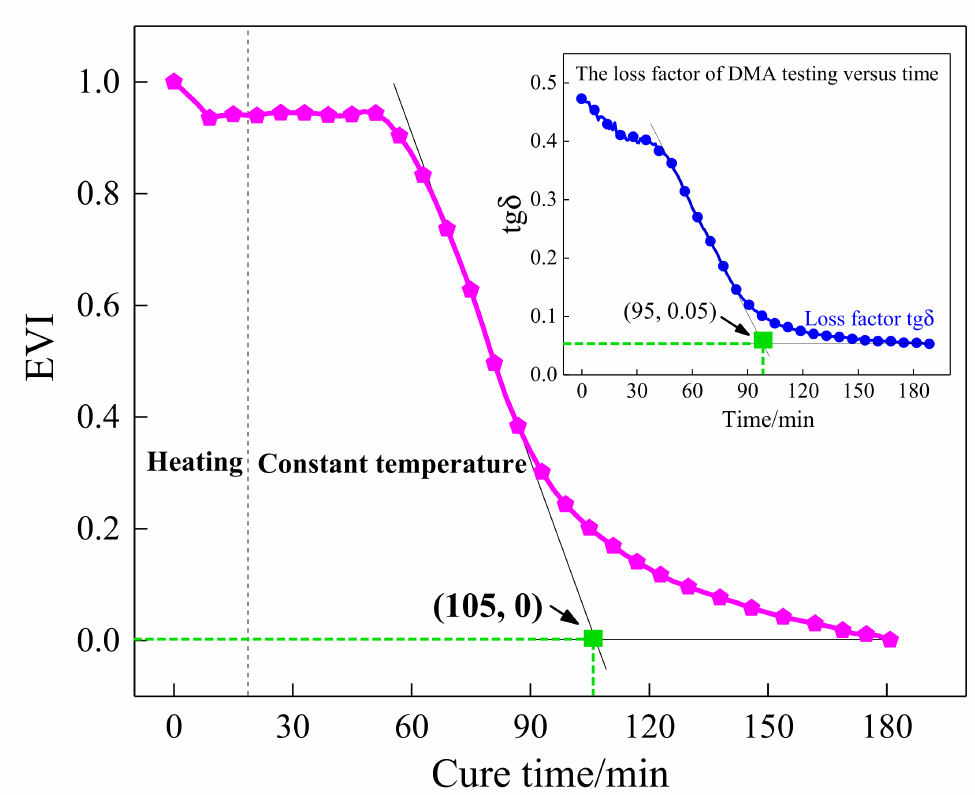
Figure 9. The schematic diagram of the calculated EVI of the sensing path